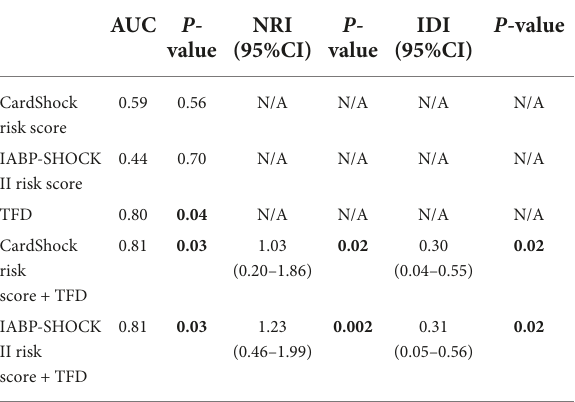
TABLE 7 Risk prediction models.